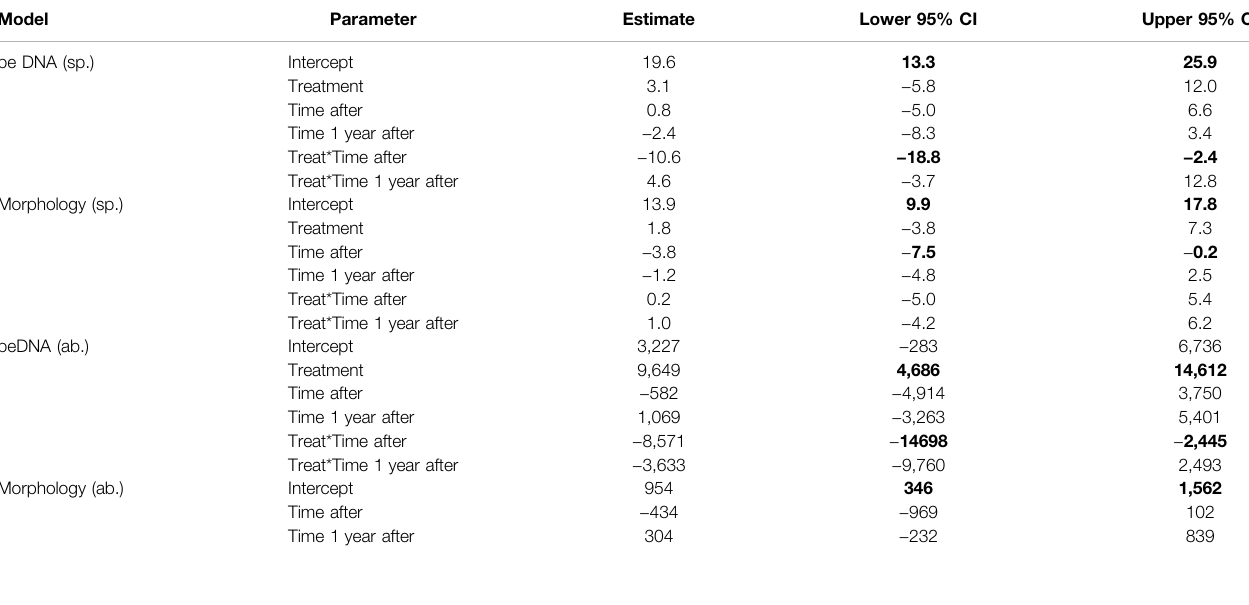
TABLE 2 | Fixed effects of linear mixed effects models of morphological and peDNA samples. Time after = 2 weeks after the rotenone treatment, Time 1 year after = 1 year after the rotenone treatment. The number of taxa (sp.) and abundance (ab.) determined with either morphological or peDNA based methodology were dependent variables. Rotenone treatment and time and the interaction between treatment and time were fi xed variables; lakes were random variables in all models. The abundance models with rotenone treatment became singular fi t, and therefore, only time was a fi xed variable. Lower and upper con fi dence limits (95% CI) for statistically signi fi cant covariates (i.e., not overlapping zero) are highlighted in bold. Model Parameter Estimate Lower 95% CI Upper 95% CI pe DNA (sp.)